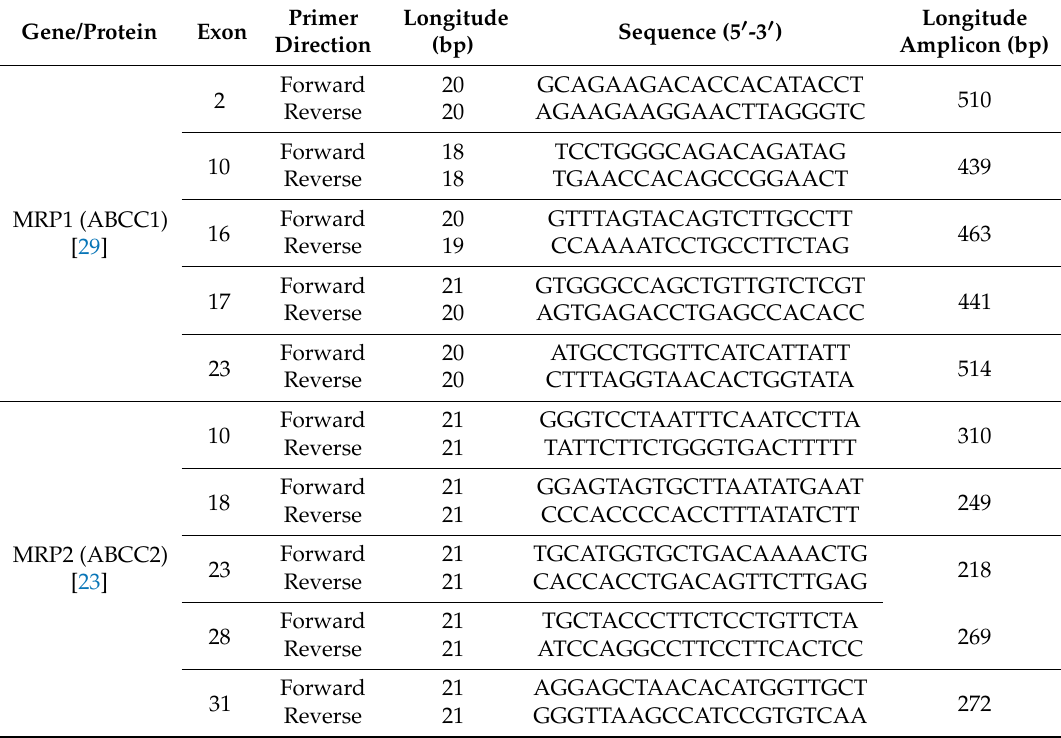
Table 2. The primers for the sequence amplification of